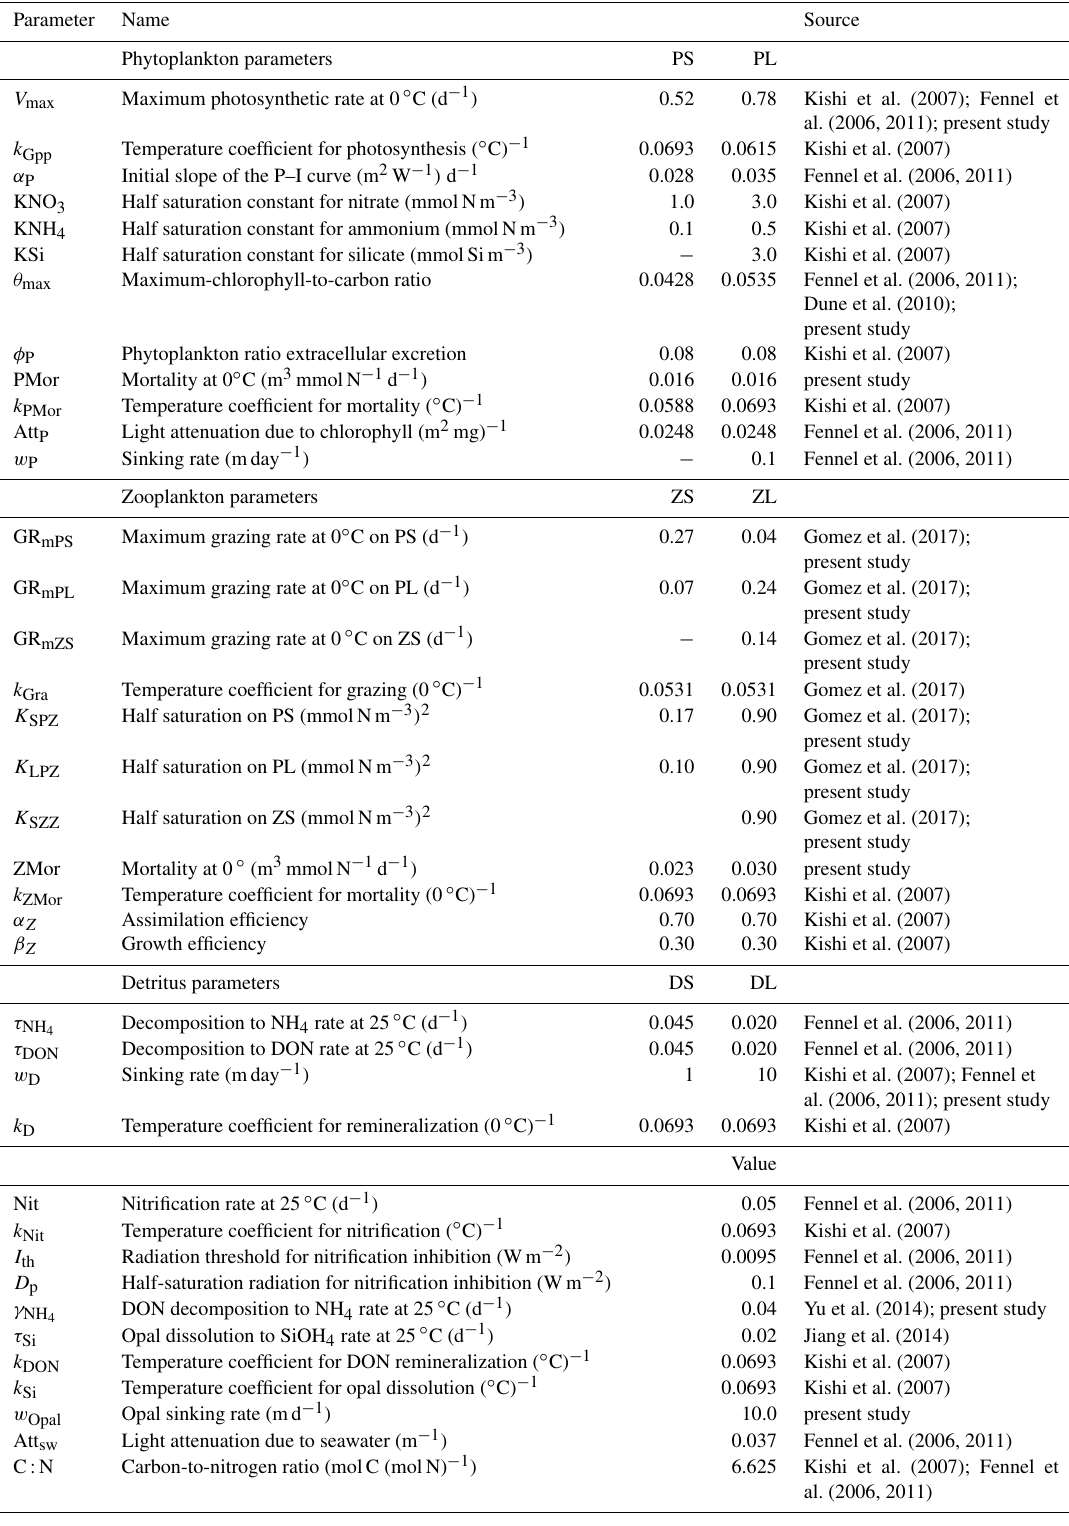
Table 1. Model parameter